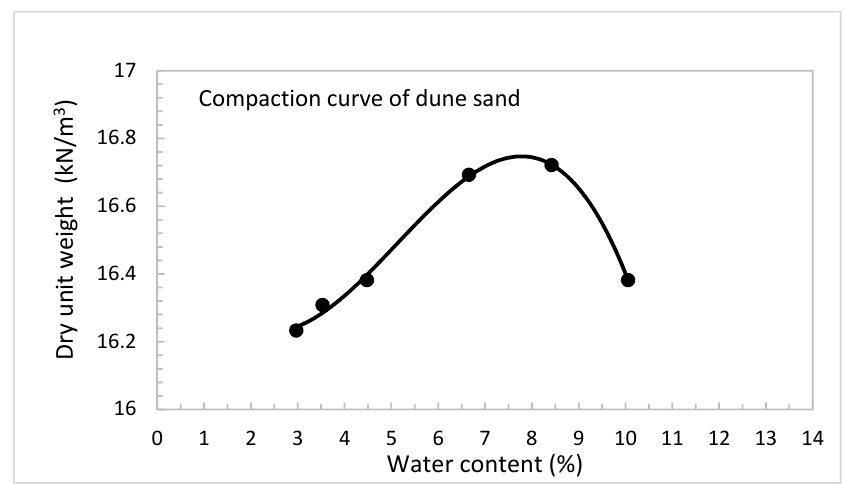
Figure 3. Standard proctor compaction curve of dune sand. Table 3. Physical and engineering testing program of the treated dune sand. Table 4. Tested samples for Raman spectroscopy and laser-scanning microscopy